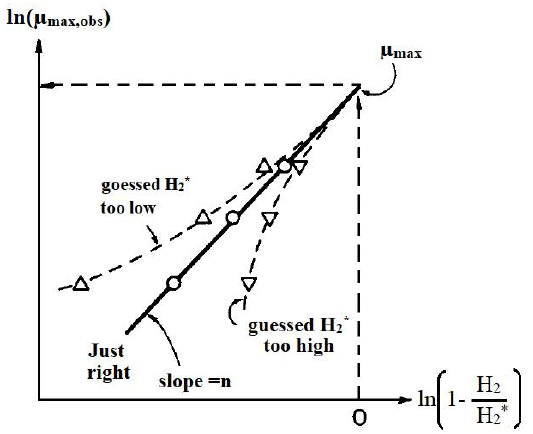
Figure 4. Evaluation procedure of u max , n and H 2 * for product inhibition; Reproduced with permission from Keehyun Han and Octave Levenspiel, Biotechnology & Bioengineering; published by John Wiley and Sons, 2004 [21].